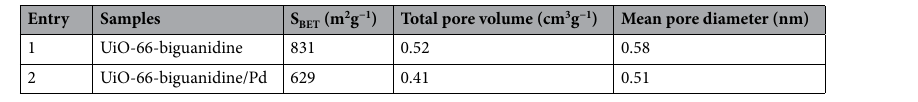
Table 1. Nitrogen adsorption–desorption data for UiO-66-biguanidine and UiO-66-biguanidine/Pd.